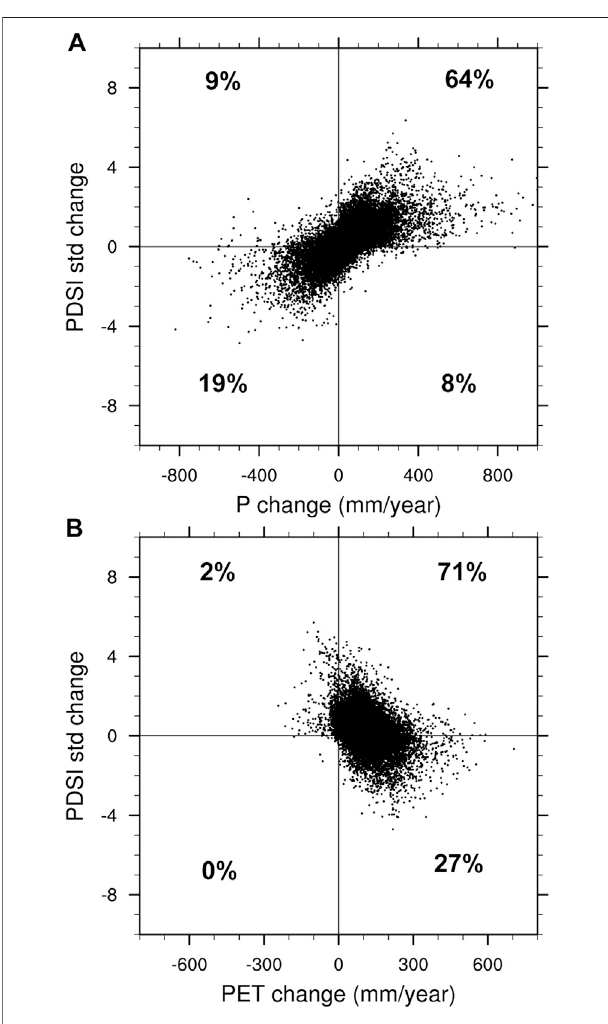
FIGURE5| ScatterplotsofthePDSIstandarddeviation(std)changevs. mean (A) precipitation (P) and (B) potential evapotranspiration (PET) changes for all grids over global land from all multi-model ensemble simulations considered in this study under the RCP4.5 emission scenario. The four numbers in each panel represent thepercentage ofpoints inthat region tothe total number of points.